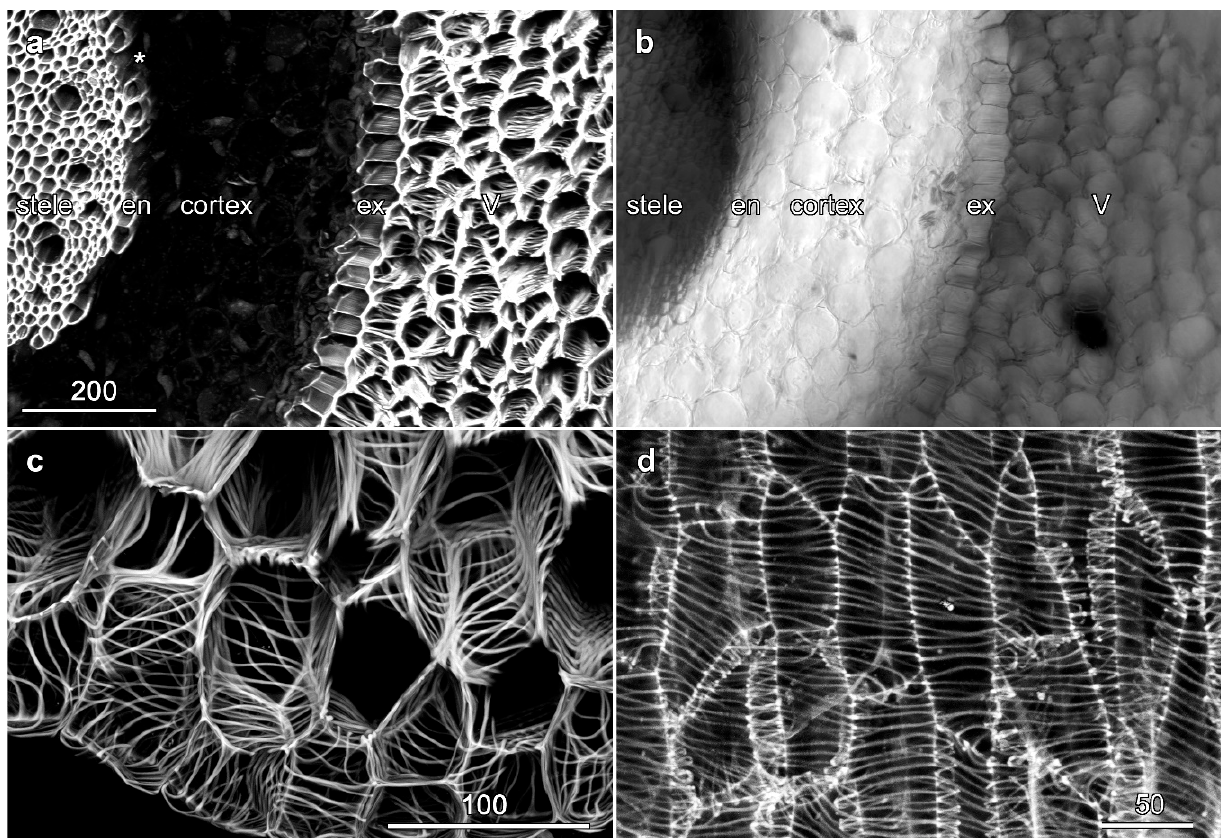
Figure 4. Velamen organization in Dendrobium sp. roots. Images ( a , c , d ) are maximum projections of confocal optical series collected from basic fuchsin fluorescence. ( a , b ) A slightly off-angle cross section showing lignified cell walls, along with a concurrent transmitted light image. The velamen (V) surrounds the lignified exodermis (ex) and the cortex. The partially lignified endodermis (en) with multiple passage cells (*) surrounds the central stele. ( c ) Higher resolution image of crossed cell wall thickenings in the outer velamen. ( d ) Longitudinal section showing velamen cells with transverse wall thickenings on the velamen’s outer face. See also Supplementary Movies 5 and 6. Bar in ( a ) = 200 µm for ( a , b ); bar in ( c ) =100 µm.; bar in ( d ) = 50 µm.